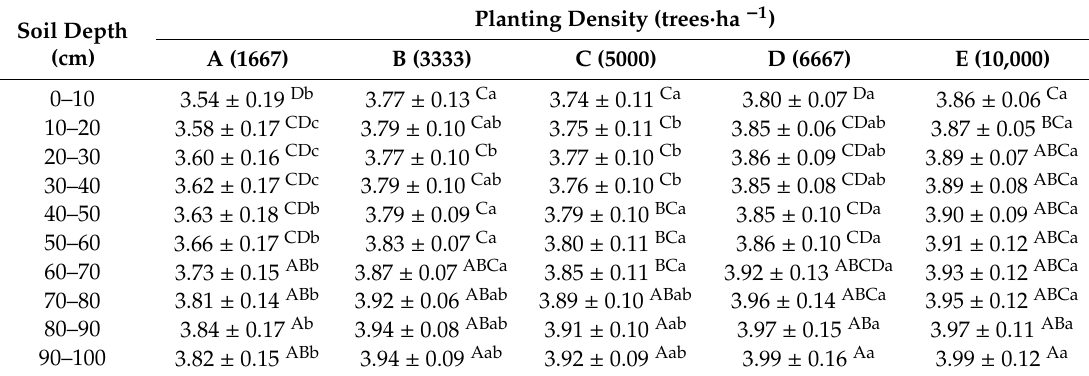
Table 3. Soil pH in di ff erent layers under di ff erent stand